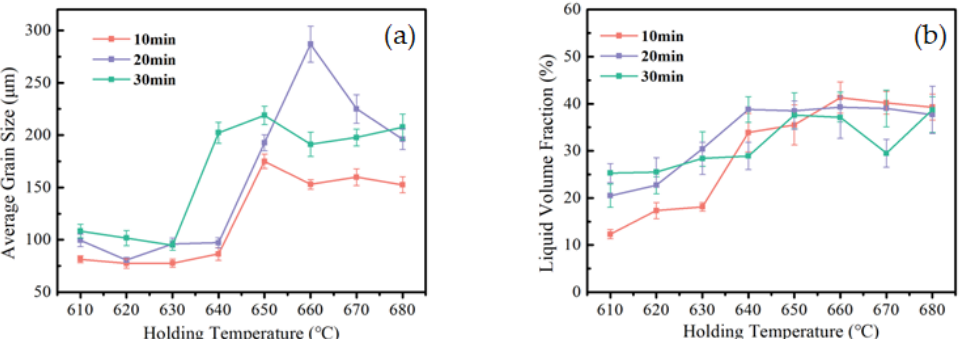
Figure 4. Quantitative analysis of microstructure at different holding temperatures; ( a ) average grain size, and ( b ) liquid volume fraction.